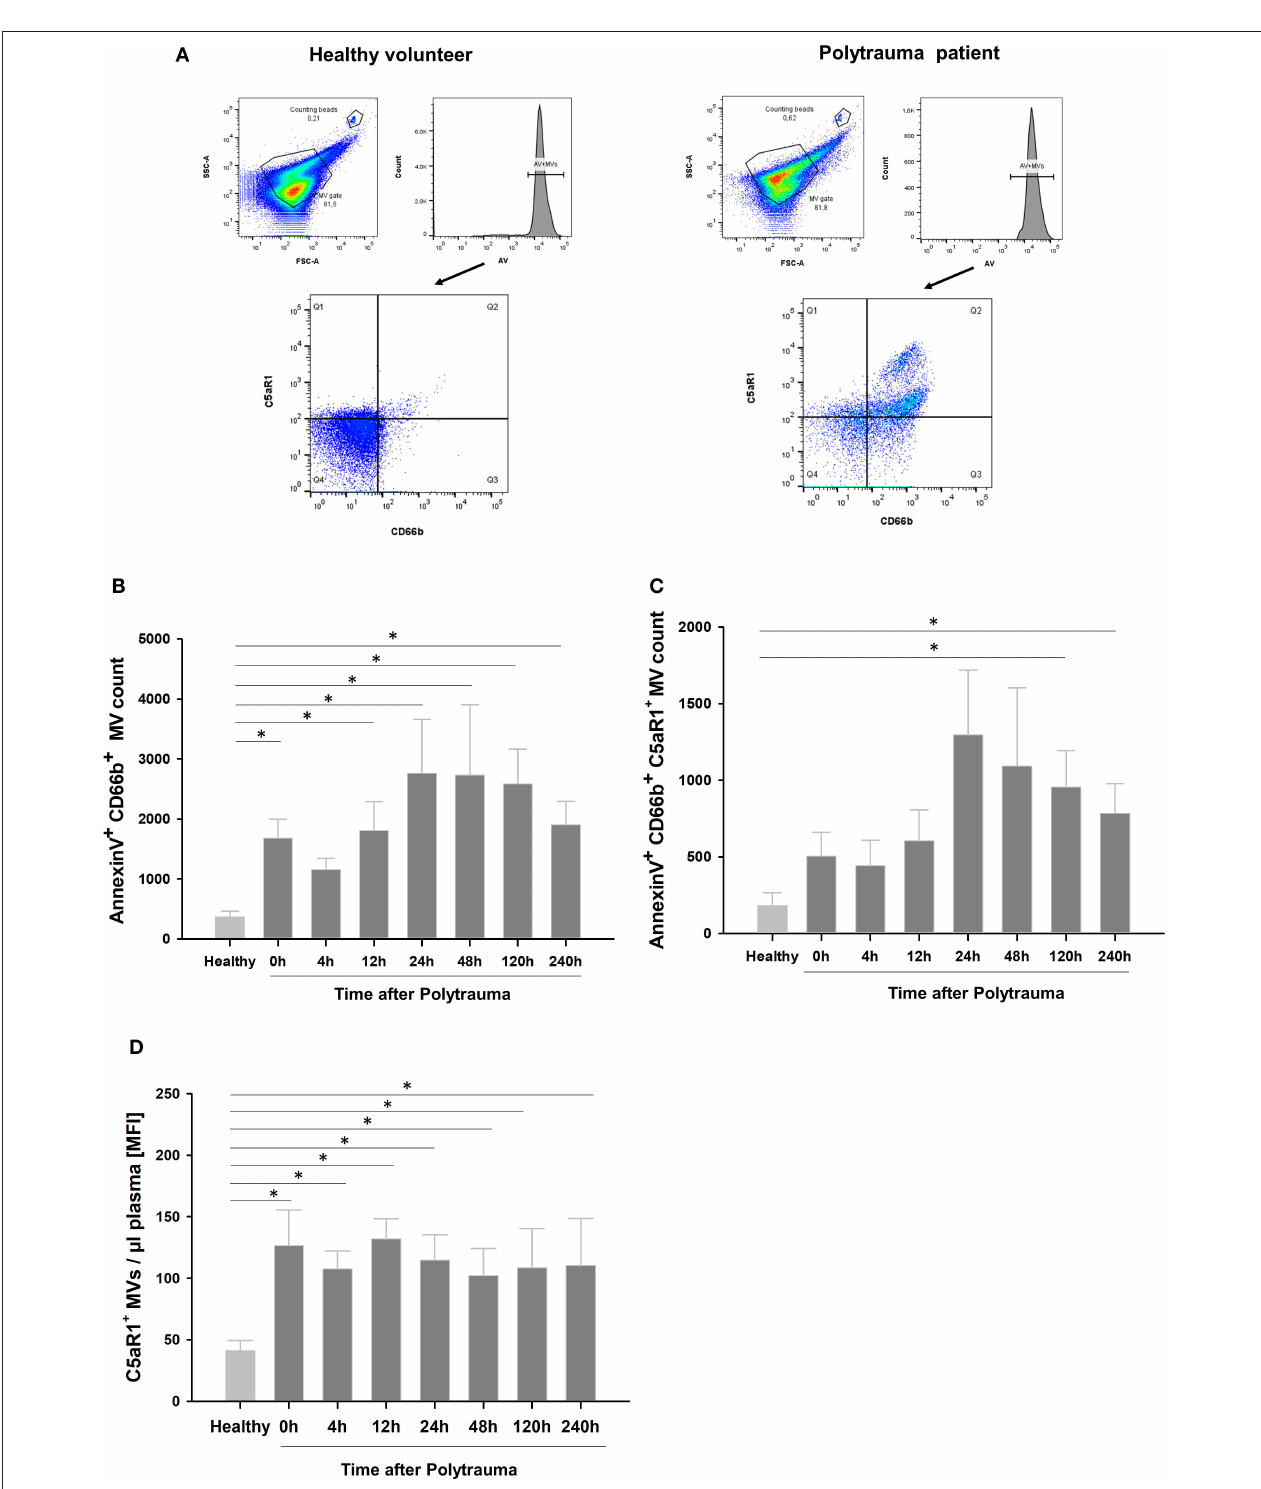
FIGURE 2 | Expression profile of shed MVs in multiple trauma. (A) Representative dot plot of a healthy control (left) and a multiple trauma patient (right). Annexin V- positive MV fraction was analyzed for CD66b and C5aR1 expression. FITC was used for C5aR1 staining, and APC-Cy7 for CD66b. Q2 represents AnnexinV + , C5aR1 + , CD66b + MVs positive MV fraction. (B) Quantitative analysis for granulocyte-derived MVs and (C,D) granulocyte-derived MVs expressing C5aR1 in 5 µ l of MV enriched plasma, respectively. n = 8–10, * p < 0.05 compared to healthy.